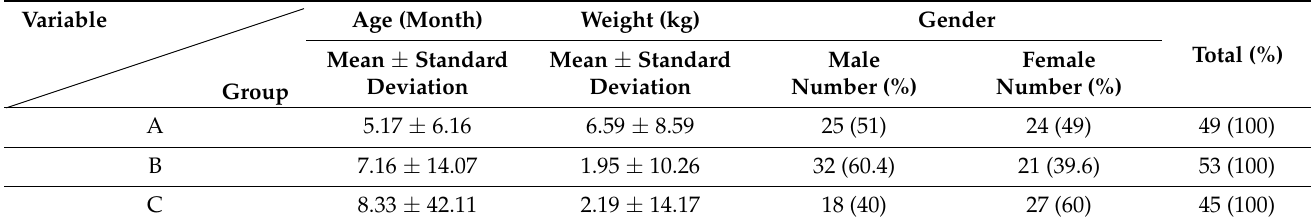
Table 1. Demographic information of the children in the three